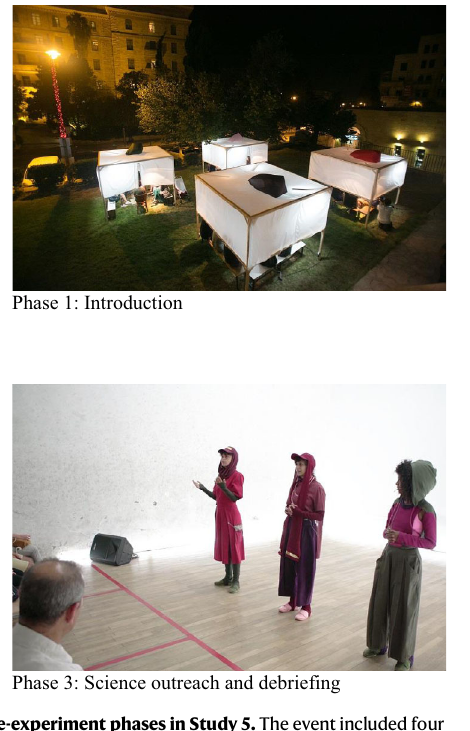
which all attendees watched a video art and a live stage performance sharing a review of the literature on outgroup empathy and the main fi ndings of this research project thus far; and (4) Open discussion in which all attendees could share their experience with each others and talk directly with the research